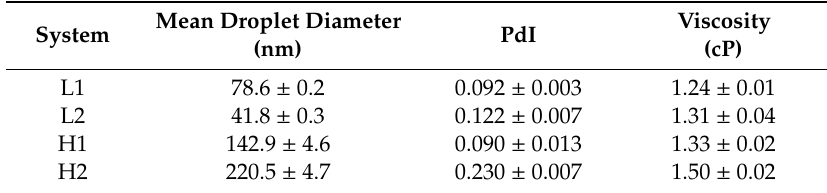
Table 2. Mean droplet diameter, PdI and viscosity of the o / w nanoemulsions measured immediately after